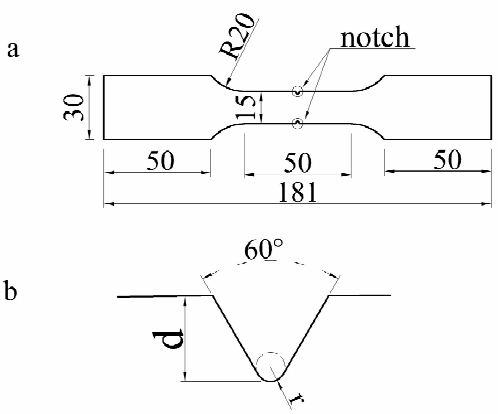
Figure 1. Shape and dimensions of plate specimens; ( a ) specimen size and geometry (unit: mm), ( b ) definition of notch size and geometry. Table 1. Summary of notch depth and root radius of specimens.